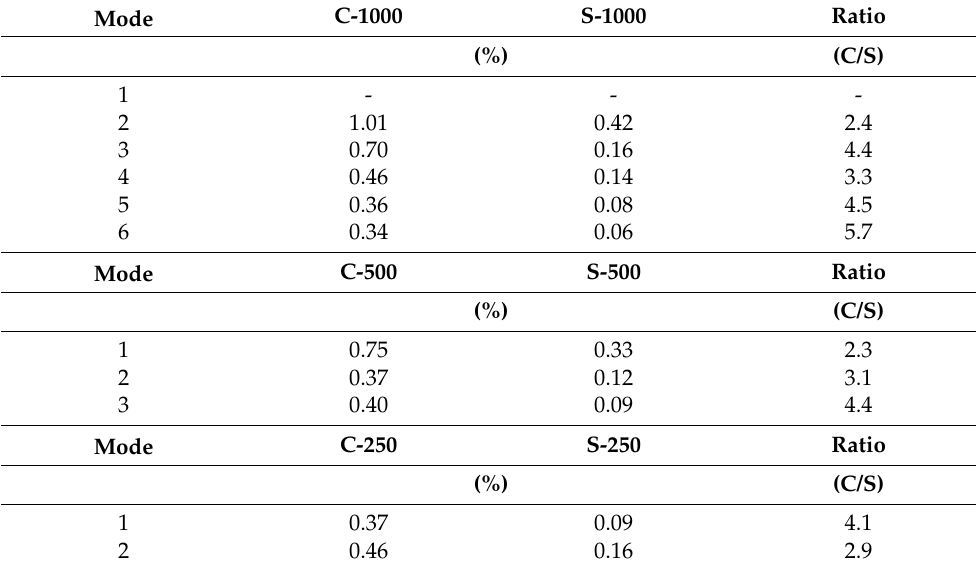
Table 16. Damping ratio − ξ n